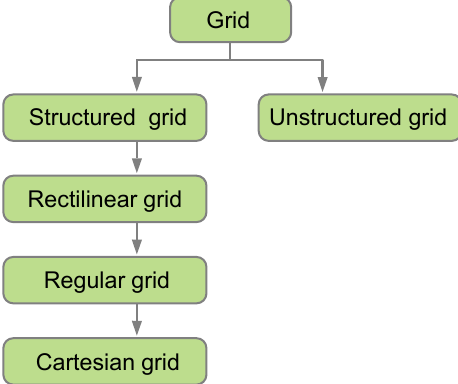
Figure 5. Hierarchy of grid data types in OMUSE. Arrows denote inheritance of the corresponding classes in